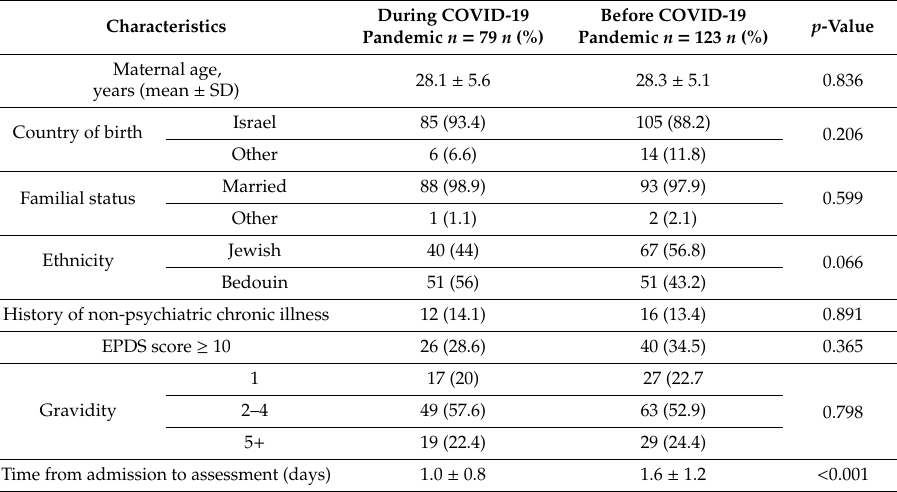
Table 1. Maternal clinical and demographic